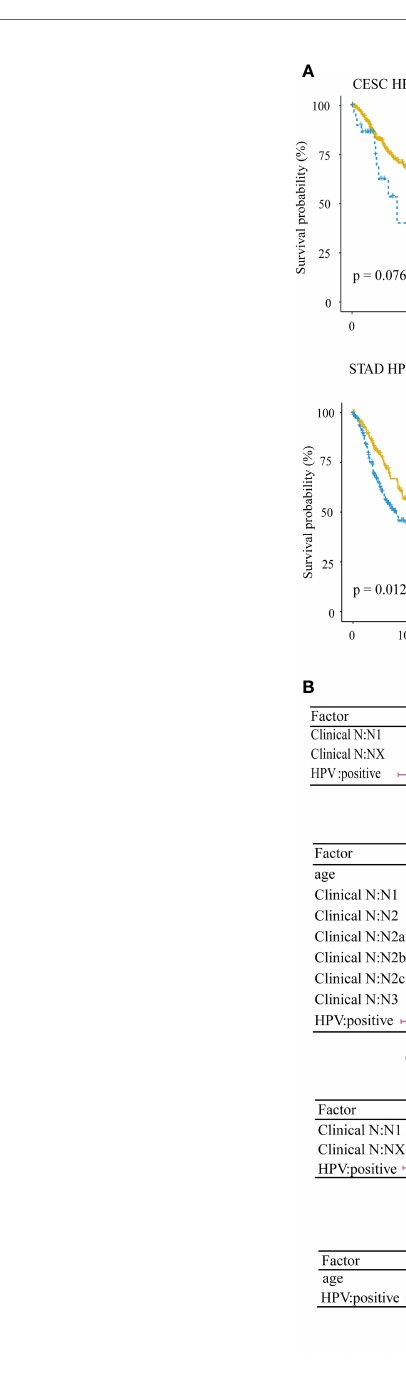
FIGURE 1 | Survivalanalysisfor HPV-relatedcancer. (A) TheHPV-positivegrouphadsigni fi cantlyhigher survivalratescomparedwiththeHPV-negativegroupinfourcancer types(CESC,cervicalsquamouscellcarcinoma; HNSC, headandnecksquamous cellcarcinoma; STAD,stomachadenocarcinoma;UCEC,uterinecorpusendometrial carcinoma). (B) Forest plotofthemultivariateCoxregressionanalysisofHPVandclinicalindicators withstepwise selection.Theredhorizontallines correspond tothe95% CI,on whichthedot re fl ectsthehazardratio. (Nx,regionallymphnodescouldnotbeevaluated;N1,lymphnode metastaseswithamaximum diameter oflessthan3cm; N2,lymph nodemetastaseswitha maximum diameterofless than6 cm andgreaterthan3cm; N3,themaximumdiameter